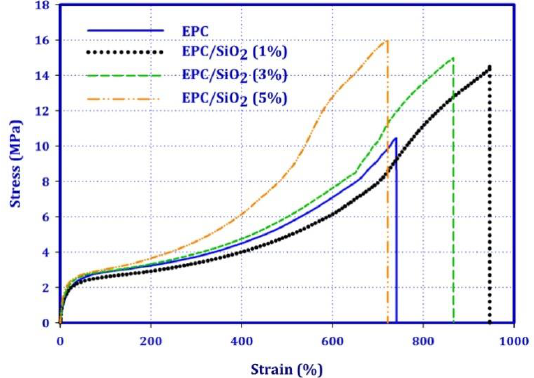
Figure 4. Stress-strain curves for the EPC and its nanocomposites reinforced with 1 wt.%, 3% wt.%, and 5 wt.% of SiO 2 .